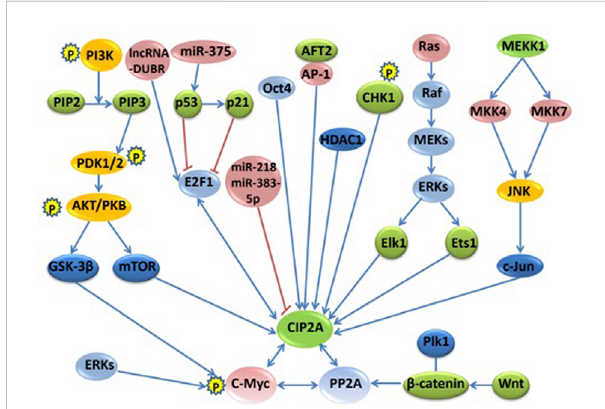
FIGURE 1 The signaling pathways and regulation networks of CIP2A/p90. Several signaling pathways, including the PI3K – AKT – mTOR pathway, the RAS – MEK – ERK pathway, the Wnt – β -catenin pathway, the MKK4/ MKK7-JNK-c-Jun pathway, the p53-p21-E2F1-CIP2A/ p90 pathway, and the phosphorylation and degradation of c-Myc, non-coding RNAs, and other regulation factors, such as Oct4, AFT2, CHK1,andHDAC1,areincludedinthis fi gure.Bidirectionalbluearrows indicate interactions between two entities; unidirectional blue arrows indicate a positive in fl uence of an entity on another; red lines indicate a negative in fl uence of one entity on